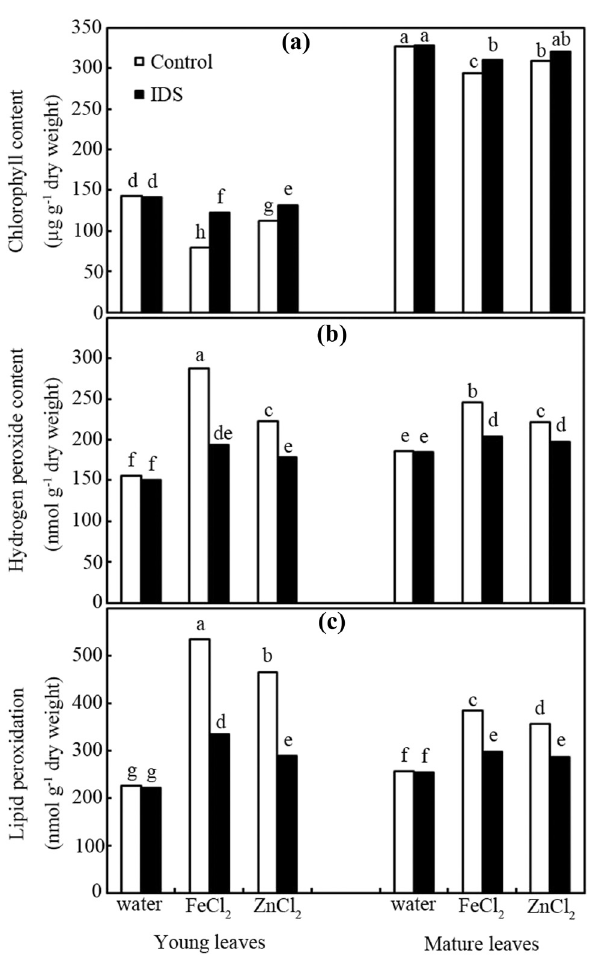
Figure 1: Oxidant damage in jujube leaves. The e ff ects of foliar spra - ying with a mineral element fertilizer in ionic ( FeCl 2 and ZnCl 2 ) and chelate ( Fe - IDS and Zn - IDS ) forms on the ( a ) chlorophyll level, ( b ) H 2 O 2 content, and ( c ) lipid peroxidation were observed in the young and mature leaves of jujube after treatment for 7 days. Mean values assigned with the same letter are not signi fi cantly di ff erent ( n = 3; p < 0.05 ) . IDS, iminodisuccinic acid.